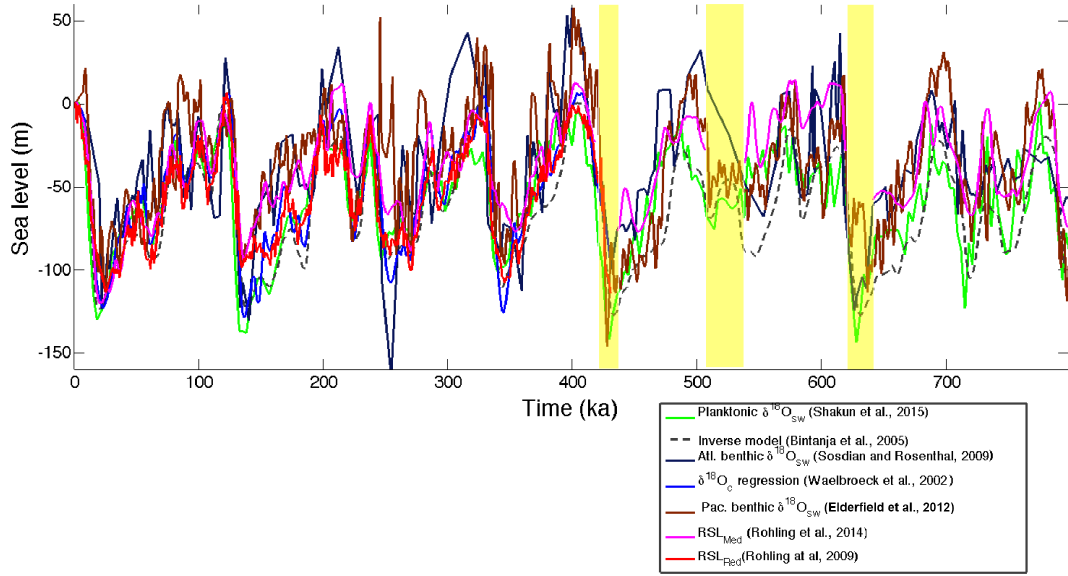
Figure 1. Eustatic and relative sea level estimates for the seven records on the LR04 age model (Lisiecki and Raymo, 2005). Yellow bars mark the sapropel layers removed from the Mediterranean RSL record (Rohling et al.,